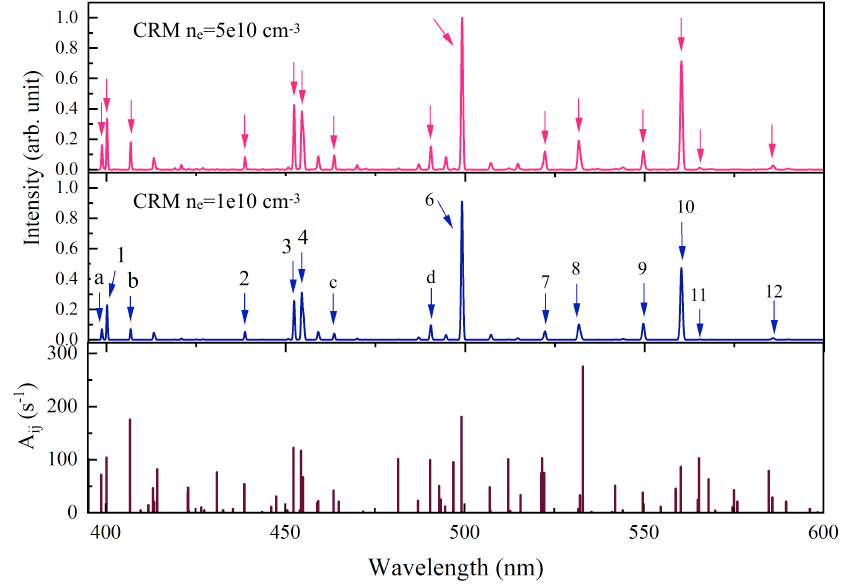
Figure 2. Theoretical spectra obtained at E e = 280 eV and n e = 1 × 10 10 cm − 3 and 5 × 10 10 cm − 3 . W 13 + lines, which were also observed in the experimental spectra at 280 eV, are shown by arrows with numbers and additional lines presented only in theoretical spectra are indicated by a, b, c, d. Lower panel shows the transition